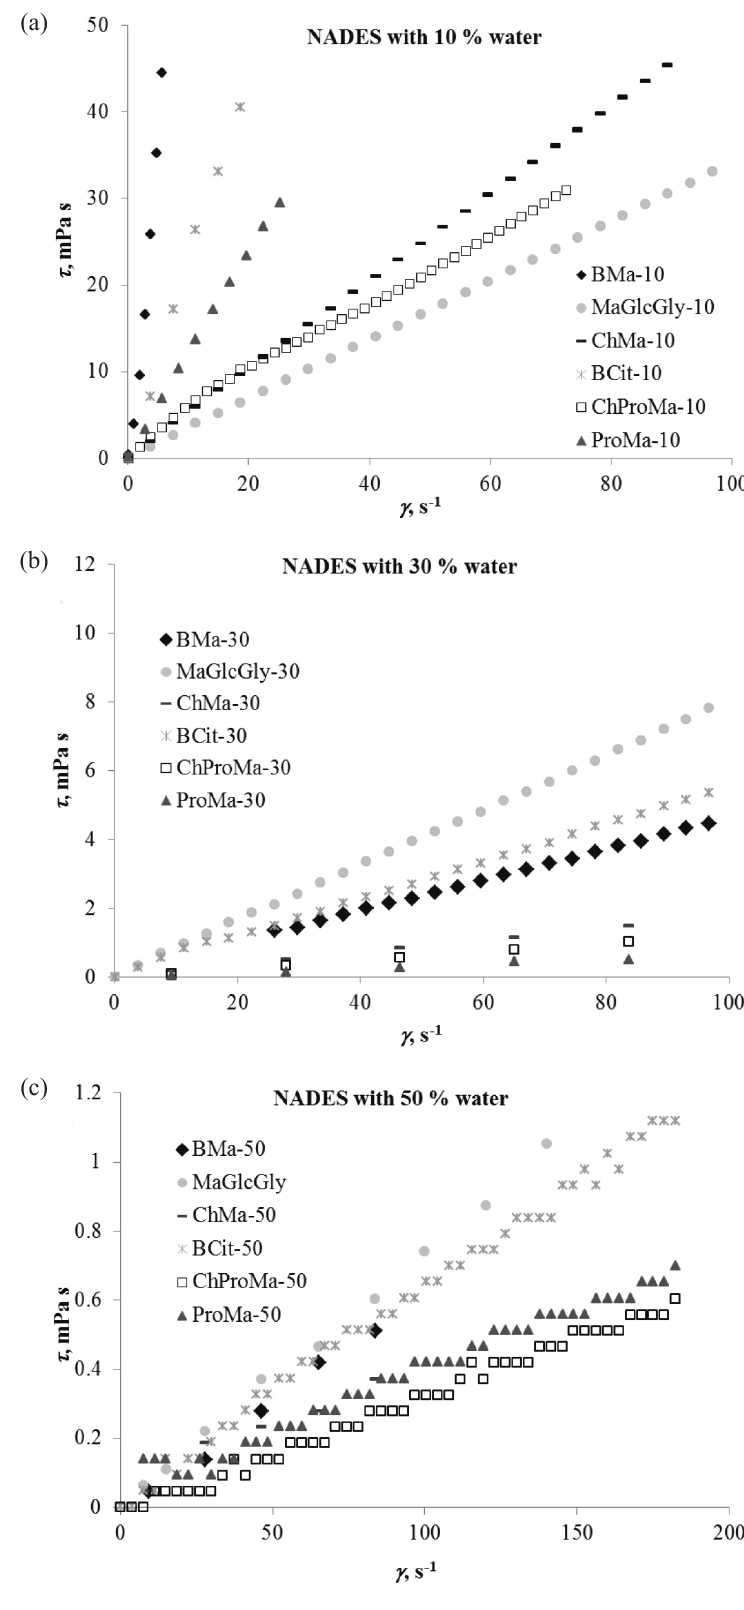
Fig. 1 S – Influence of shear stress, t on shear rate, g for NADES with 10 % (w/w) (a), 30 % (w/w) (b), 50 % (w/w) (c)